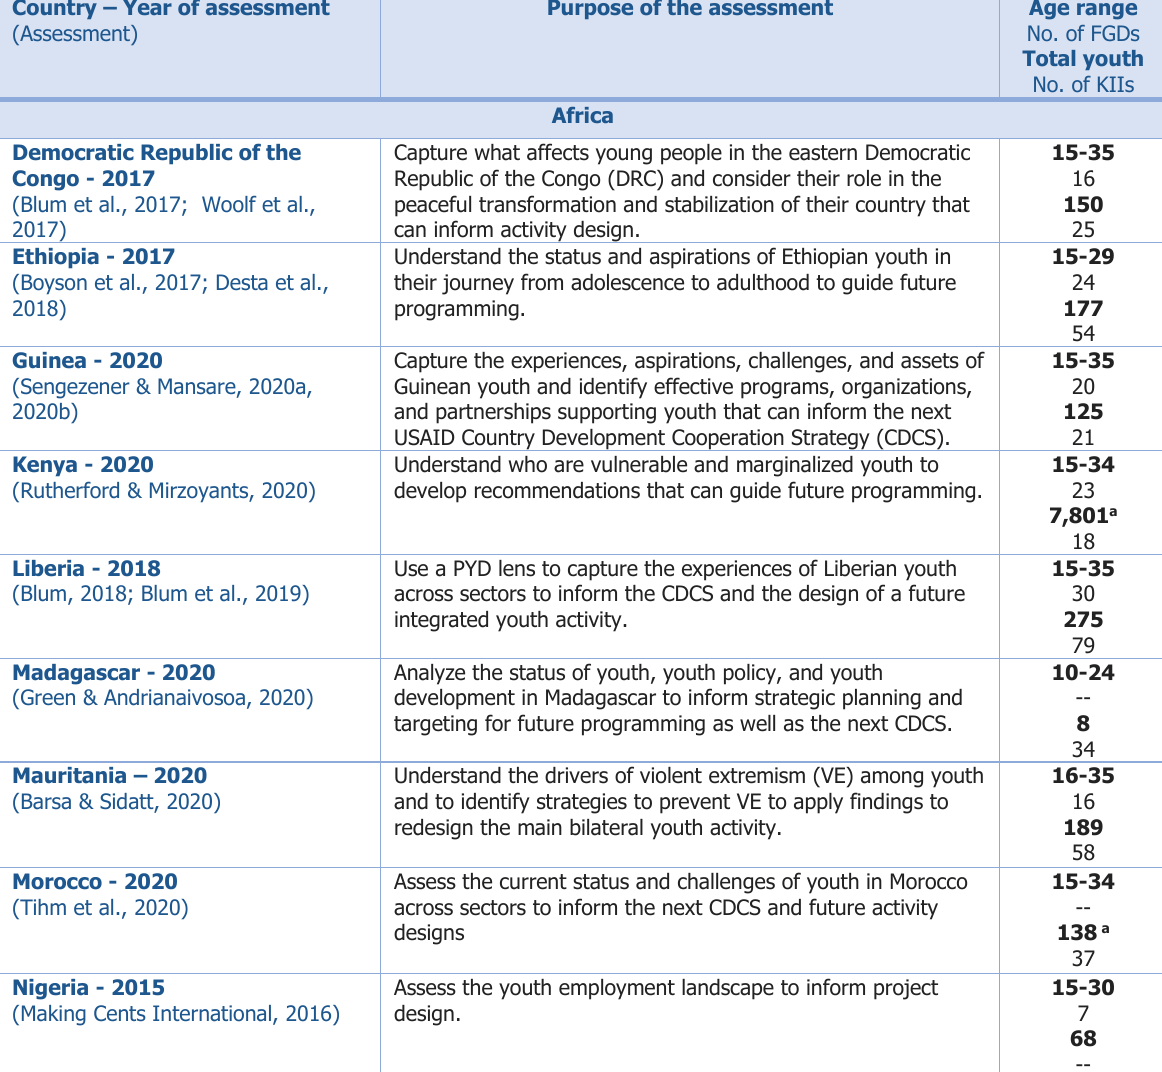
Table 2. Purpose and Methodology of the Youth Assessments